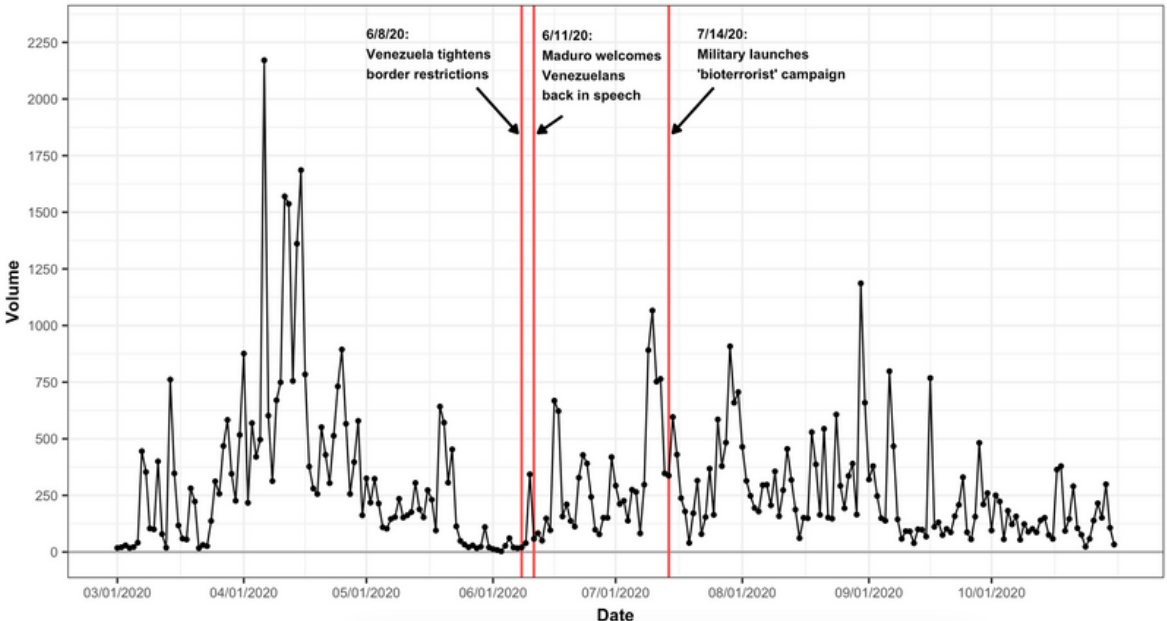
Figure 5. Time-series plot for Venezuelan border restrictions. From COVID